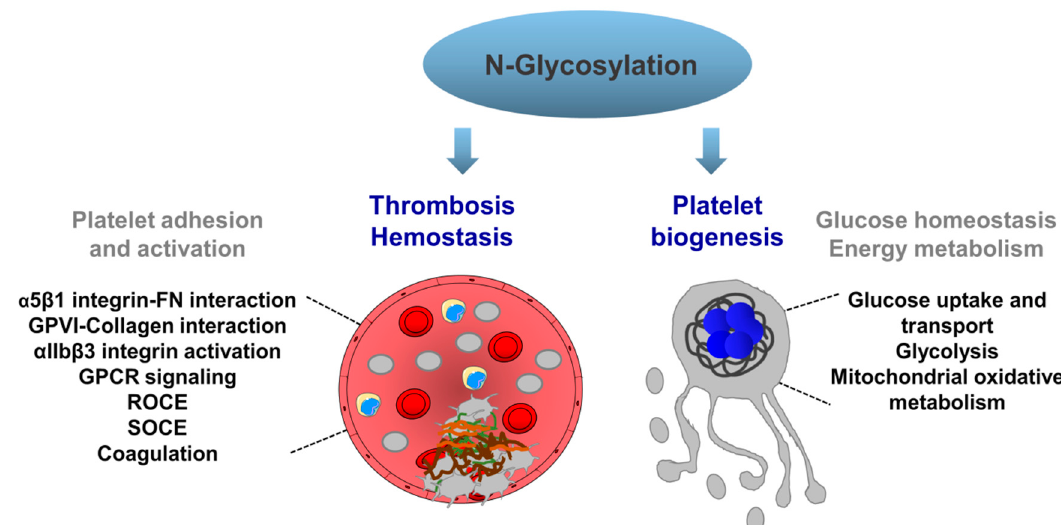
Figure 2. N ‐ glycosylation ‐ mediated mechanisms regulating pathophysiological functions in platelets and megakaryocytes. N ‐ glycosylation of platelet receptors may influence platelet adhesion, activation through regulation receptor–ligand interactions, receptor processing, and signaling activation. N ‐ glycosylation is also involved in calcium homeostasis, ROCE and SOCE in platelets. In addition, N ‐ glycosylation of platelet granule proteins and coagulation factors may regulate important steps in thrombosis and hemostasis, such as granule release, platelet procoagulancy and blood clotting. Glucose uptake and transport, glycolysis mitochondrial oxidative metabolism are regulated by proteins undergoing N ‐ glycosylation, which influence glucose homeostasis, and energy metabolism and consequently platelet biogenesis. FN: fibronectin; GPVI: Glycoprotein VI; GPCR: G ‐ protein ‐